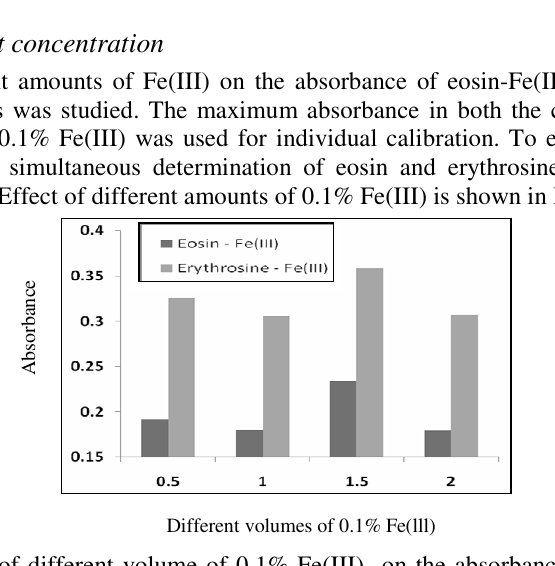
Figure 4. Effect of different volume of 0.1% Fe(III) on the absorbance of eosin - Fe(III)